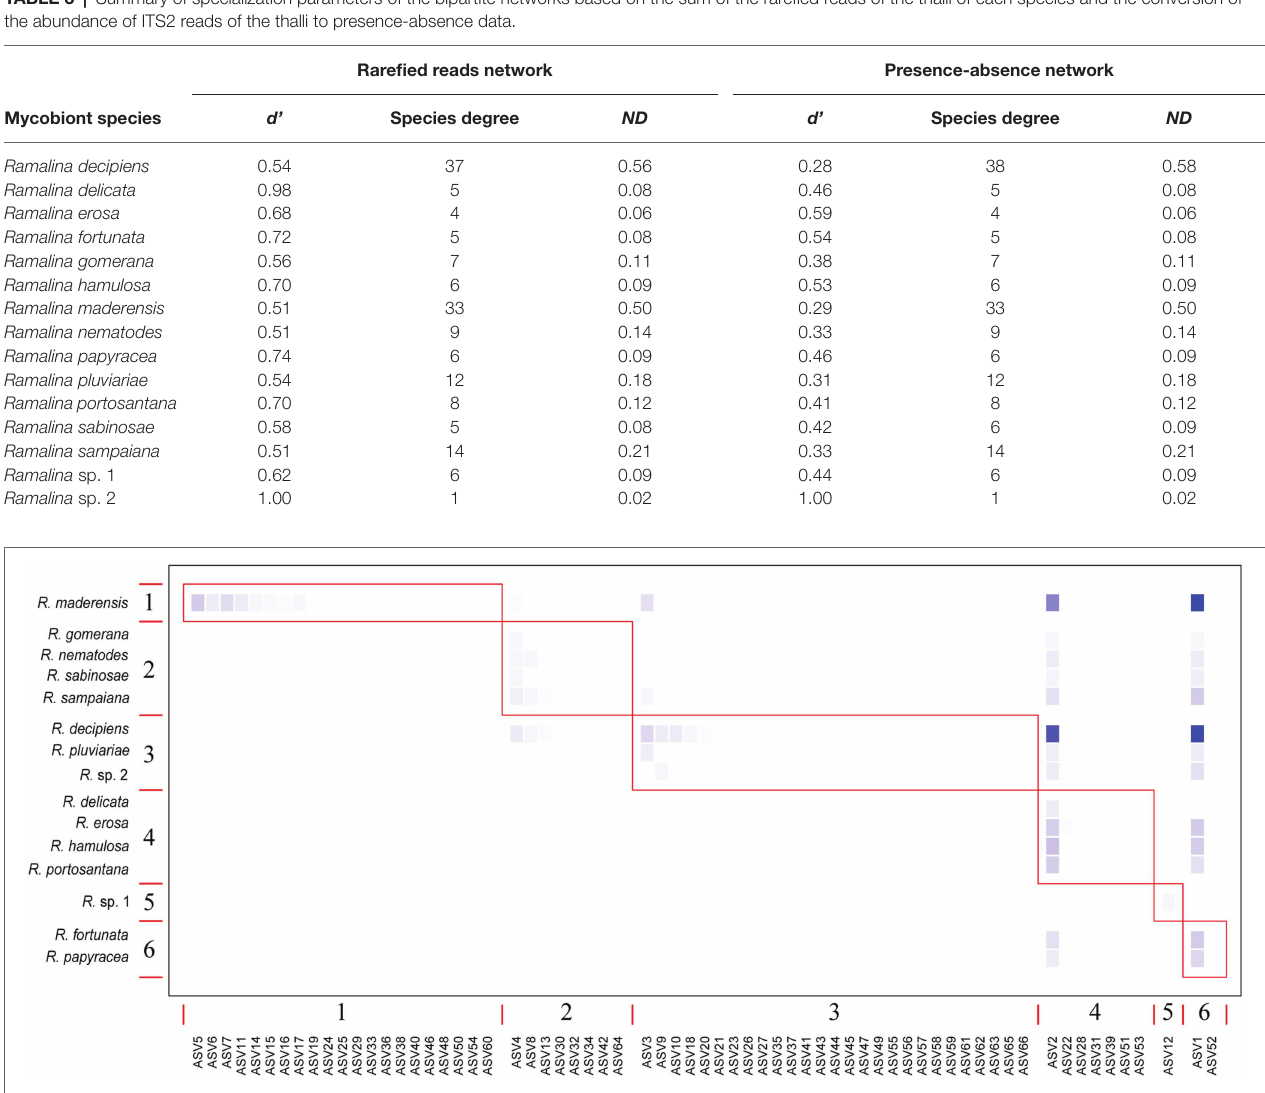
FIGURE 5 | Modularity plot featuring the six modules identified by the Becket algorithm ( Q = 0.179, z-score = 709.31; value of p <0.001) in the rarefied reads network. Taxa are sorted according to their modular affinity, mycobiont species as rows, and photobiont ASVs as columns. Red boxes delineate the six modules. Color intensity is proportional to the relative abundance of each ASV per mycobiont